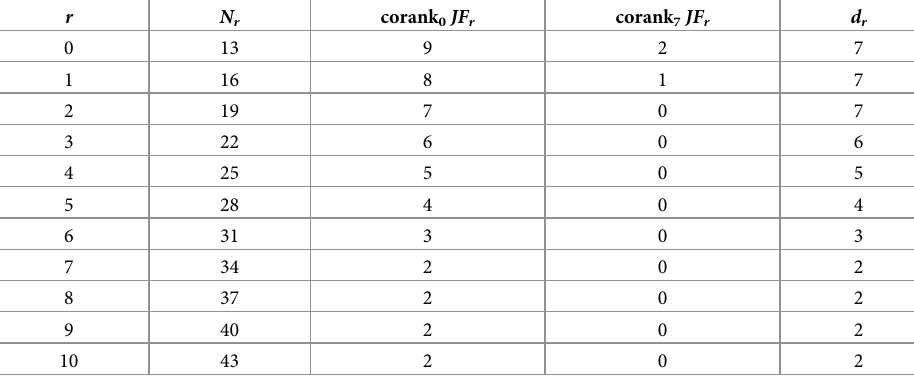
Table 1. Summary of computations showing 2 dimensions of unidentifiability. r N r corank 0 JF